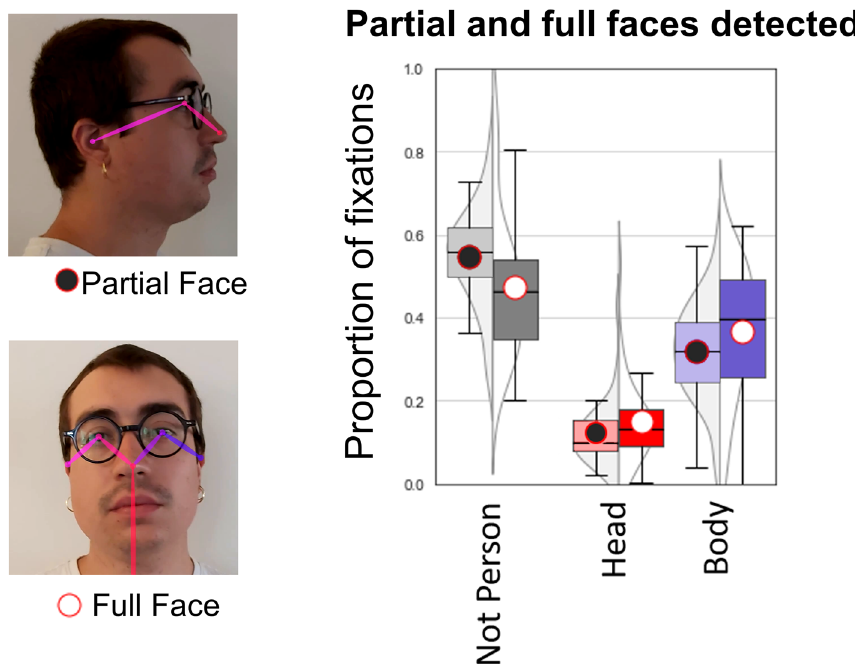
Figure 2. Comparing social attention to faces when they are fully visible versus partially visible in a video frame. Partially visible faces were due to averted head angle, or in some rare cases occlusion (top left). Results show a greater proportion of fixations to people when their faces were fully visible (see figure legend on left). See main text for analysis and Supplementary Materials (Sect. 2) for the full ANOVA and further details of the computational approach used to classify face